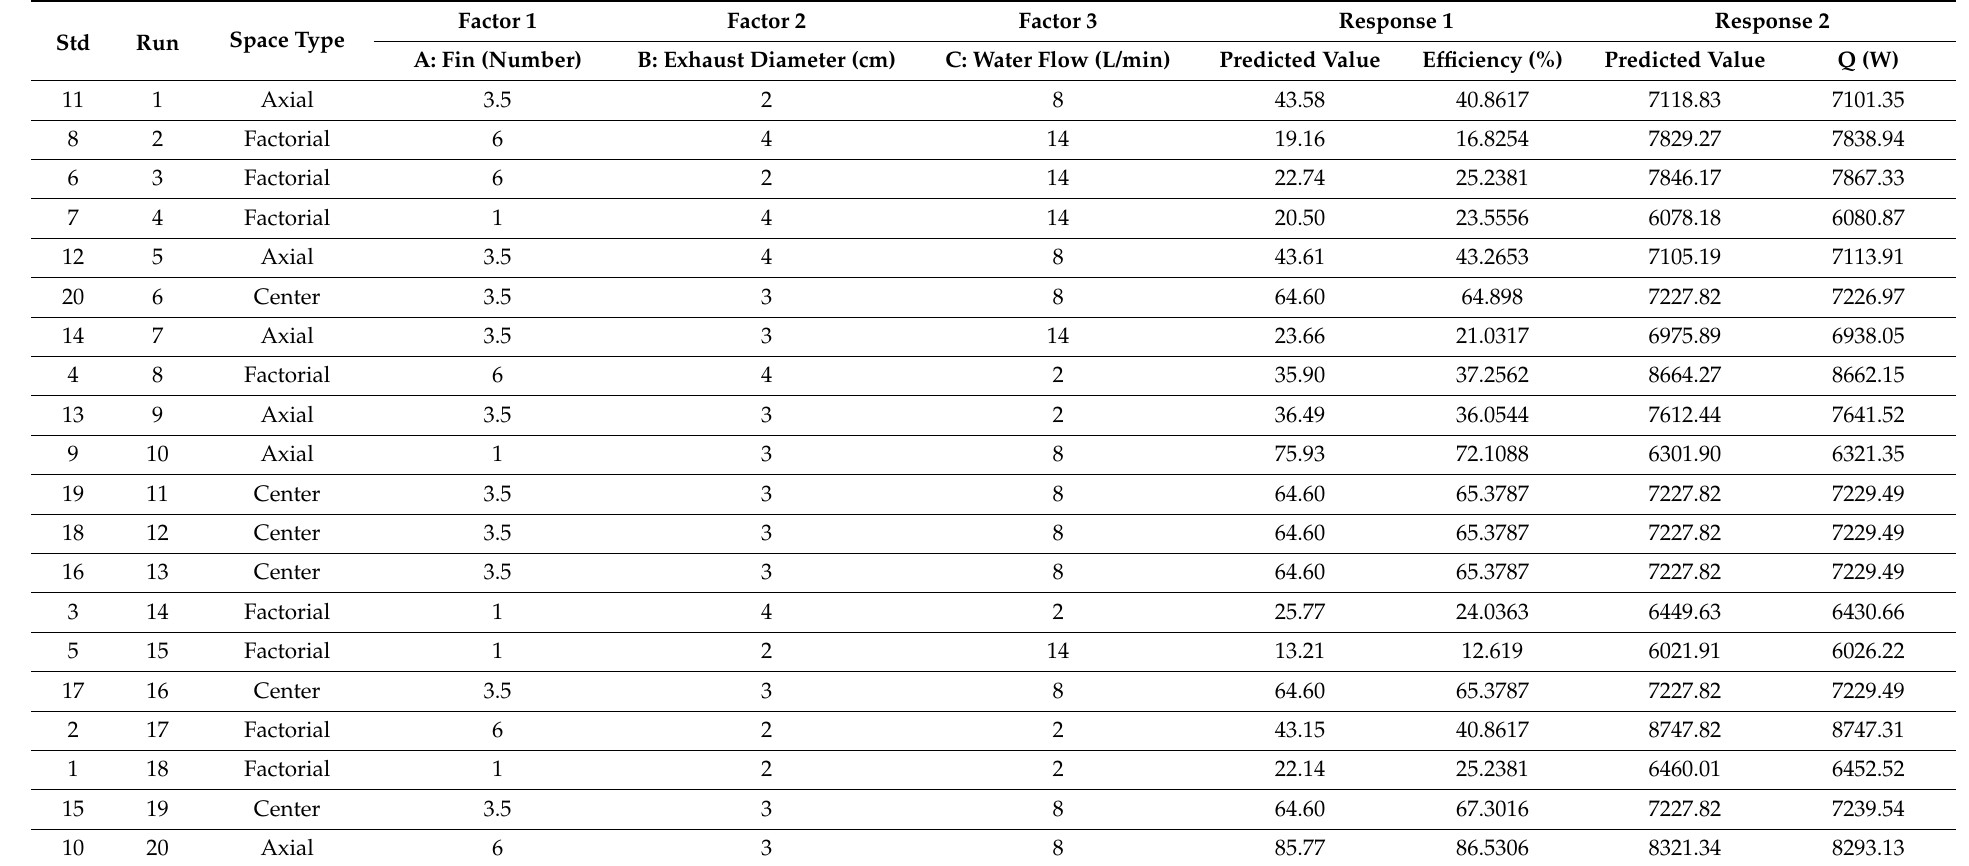
Table 3. Experimental results and their comparison with the corresponding predicted